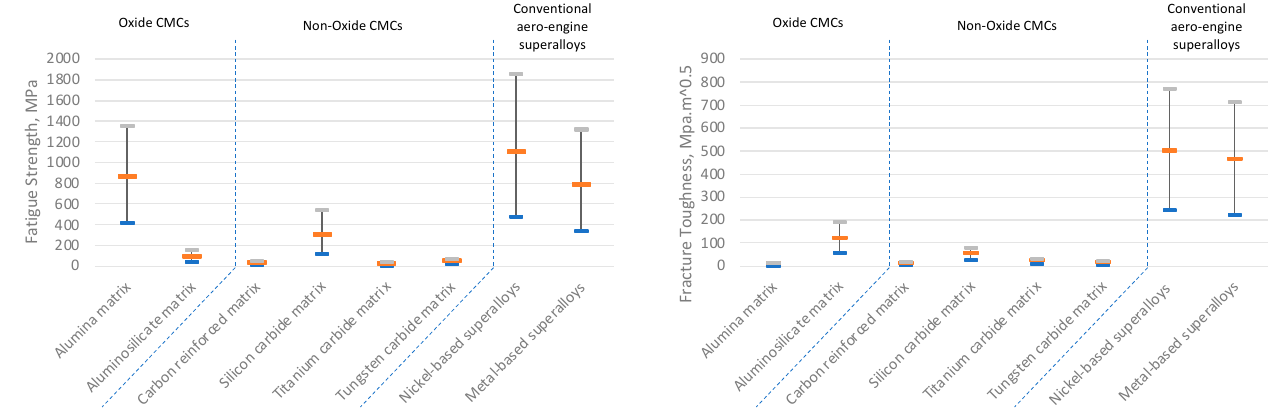
Figure 10. ( Left ) Fatigue strength at 10 7 cycles and ( right ) fracture toughness of the available CMCs and comparison with superalloys.